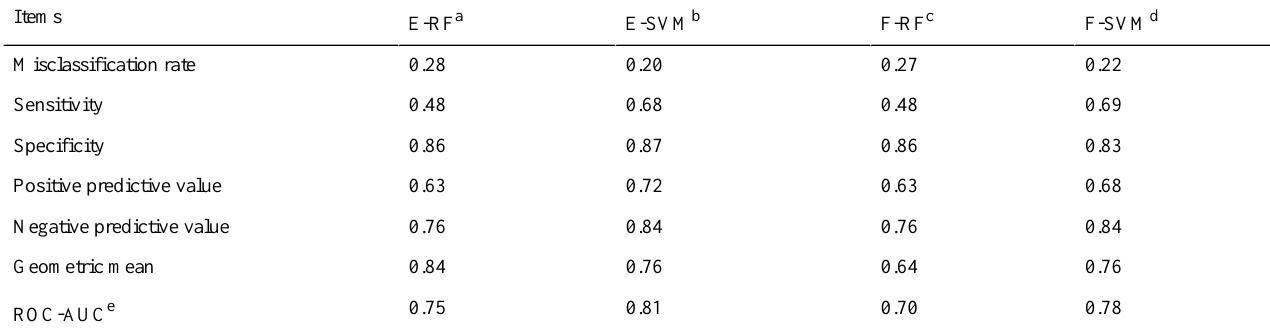
Table 4. Test data sets for each model evaluation index.